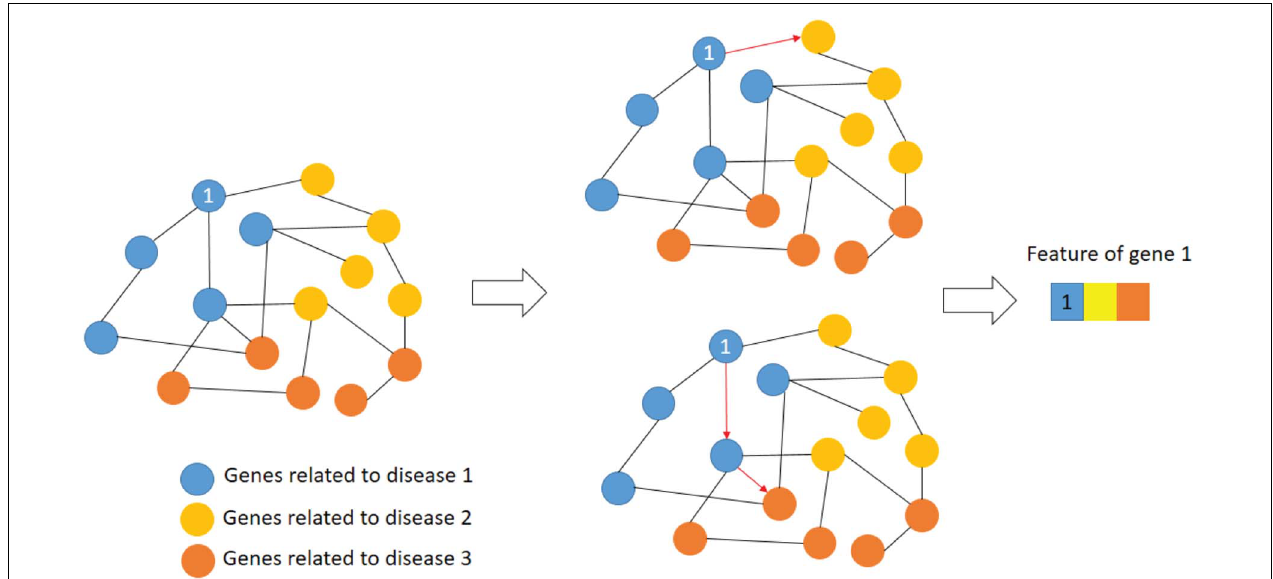
FIGURE 3 | Example of gene feature